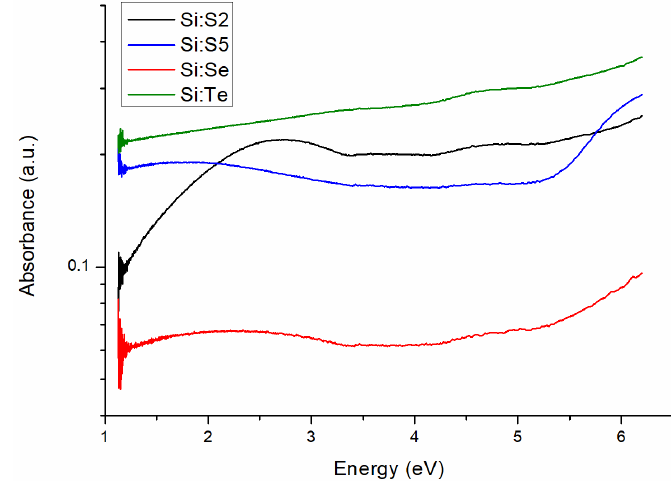
Figure 6. Absorption spectra of samples Si:S2, Si:S5, Si:Se and Si:Te.